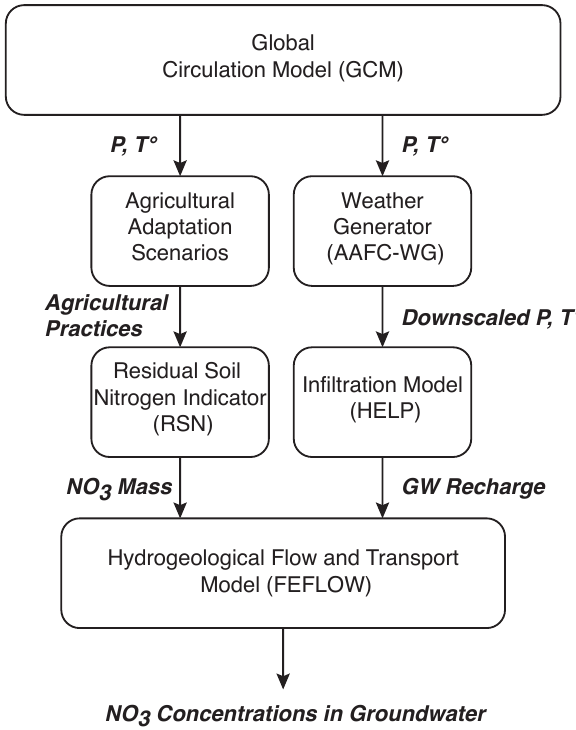
Figure 3. Workflow for the study of the potential impact of climate and agricultural practice changes on future groundwater nitrate con- centration in the Prince Edward Island aquifer